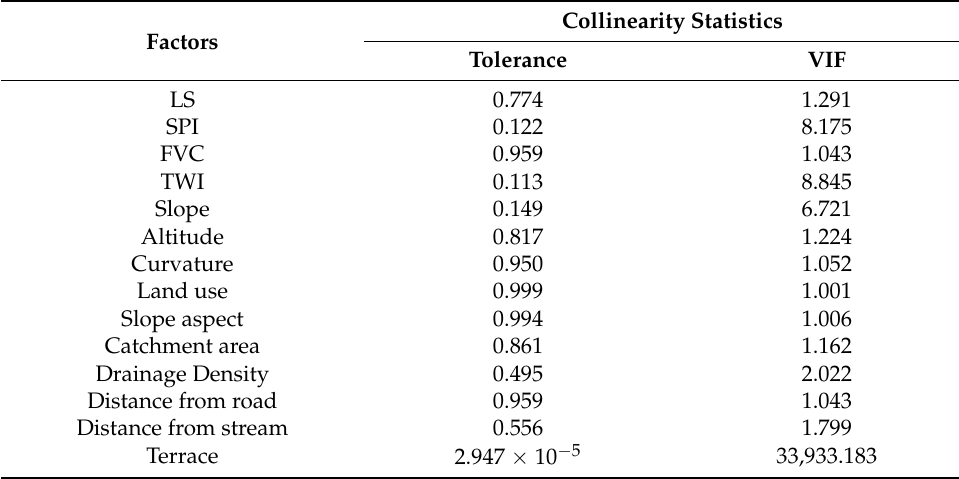
Table 1. Multi-collinearity test among gully erosion conditioning